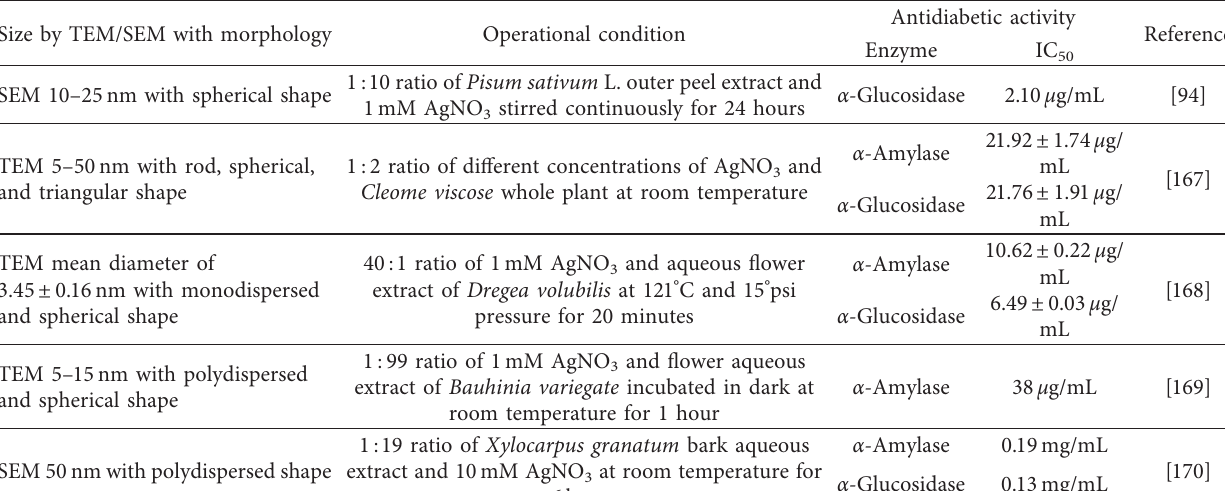
Table 5: Morphology of green synthesized Ag NPs and their antidiabetic activity. Size by TEM/SEM with